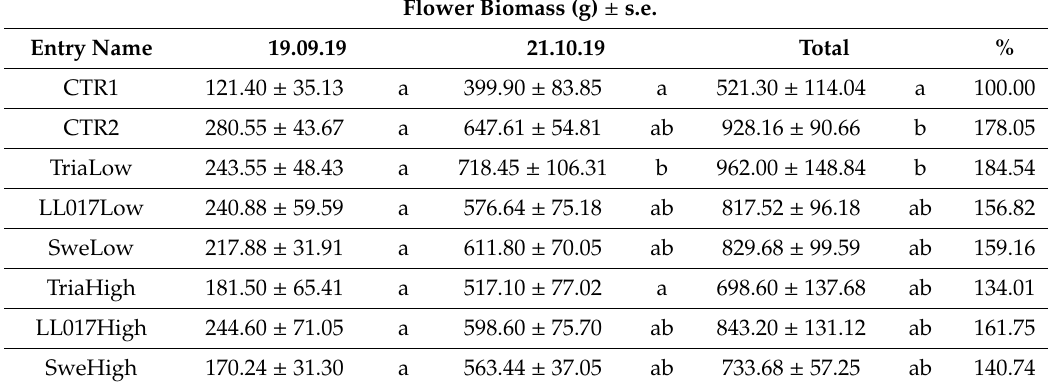
Table 2. Fresh biomass of harvested inflorescences. Flowers were manually harvested on 19.09.19 and 21.10.19. The percentage increase of the total biomass relative to CTR1 is reported on the right of the column of total yield. Three outlier values were removed by using the boxplot function (software Statistica by StatSoft) (coe ffi cient = 1.5). The statistical analysis (software Statistica by StatSoft) was performed by means of one-way analysis of variance (one-way ANOVA) with Duncan Test ( α ) = 0.1. For each trait, at least one letter in common indicates no significant di ff erence according to the Duncan